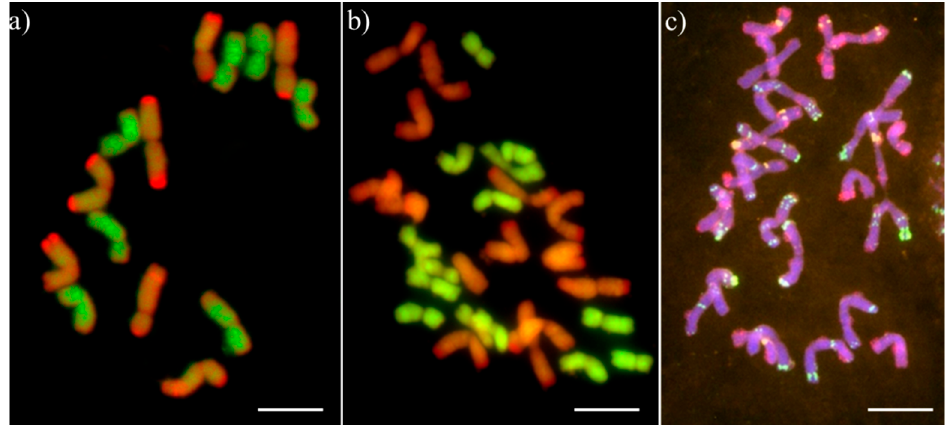
Figure 3. Chromosome sets analysed by genomic in situ hybridization (GISH) and fluorescent in situ hybridization (FISH) for ( a ) dihaploid plant (S 1 generation) and ( b ) double haploid plant (S 2 generation). A-genome chromosomes were labelled using digoxigenin-11-dUTP (green) and R-genome chromosomes were labelled with tetra-methyl 5dUTP-rhodamine (red). ( c ) FISH pattern of pTa86 (green) and pTa535 (red) probes on chromosomes of double haploid plant (S 2 generation). Scale bar: 10 μ m.